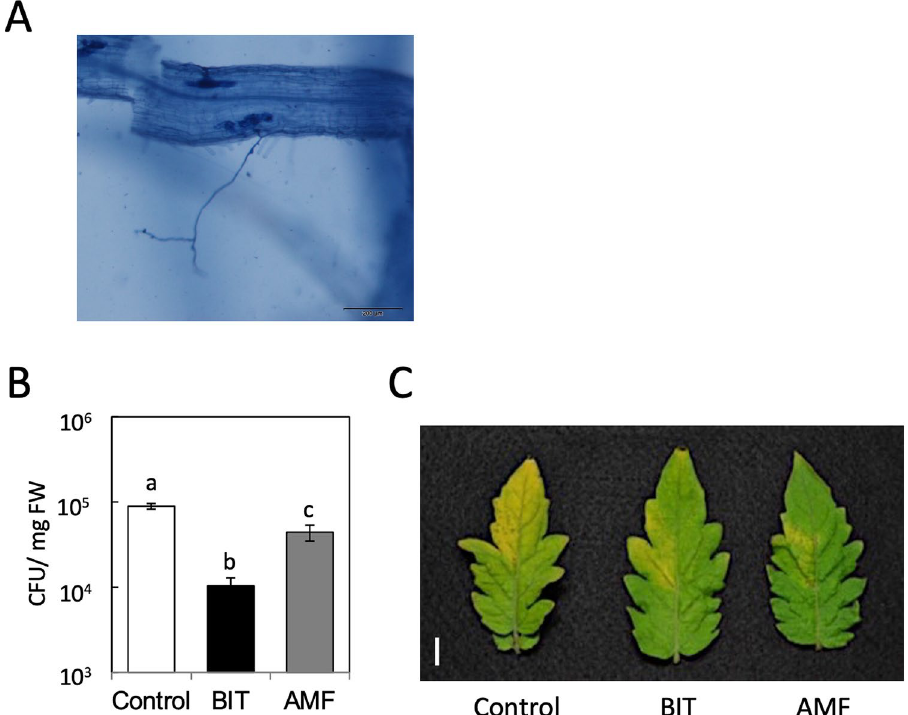
Figure 1. ( A ) Colonization of tomato root with G. margarita . Tomato plants treated with G. margarita (25 spores/pot) by soil drenching. Roots were washed and strained with trypan blue 6 days after the inoculation with G. margarita. Scale bar, 200 µm. ( B ) Induction of resistance against tomato leaf speck disease by G. margarita . Plants were treated with G. margarita (25 spores/pot) (AMF) 14 days prior to challenge inoculation with Pst (1 × 10 3 CFU/ml). SAR was induced by treatment with BIT (5 mg/pot) by soil-drenching method 5 days prior to challenge inoculation. The growth of Pst in tomato leaflet was evaluated 2 days after the inoculation. Each experiment was done with more than 4 plants. Values are shown as the means ± SE (n = 8) of a single experiment. Different letters indicate statistically significant differences between treatments (one-way ANOVA with Tukey’s post-test, p < 0.05). The experiment was repeated three times with similar results. ( C ) Photograph of representative disease symptoms taken 5 days after inoculation with Pst . Scale bar, 10